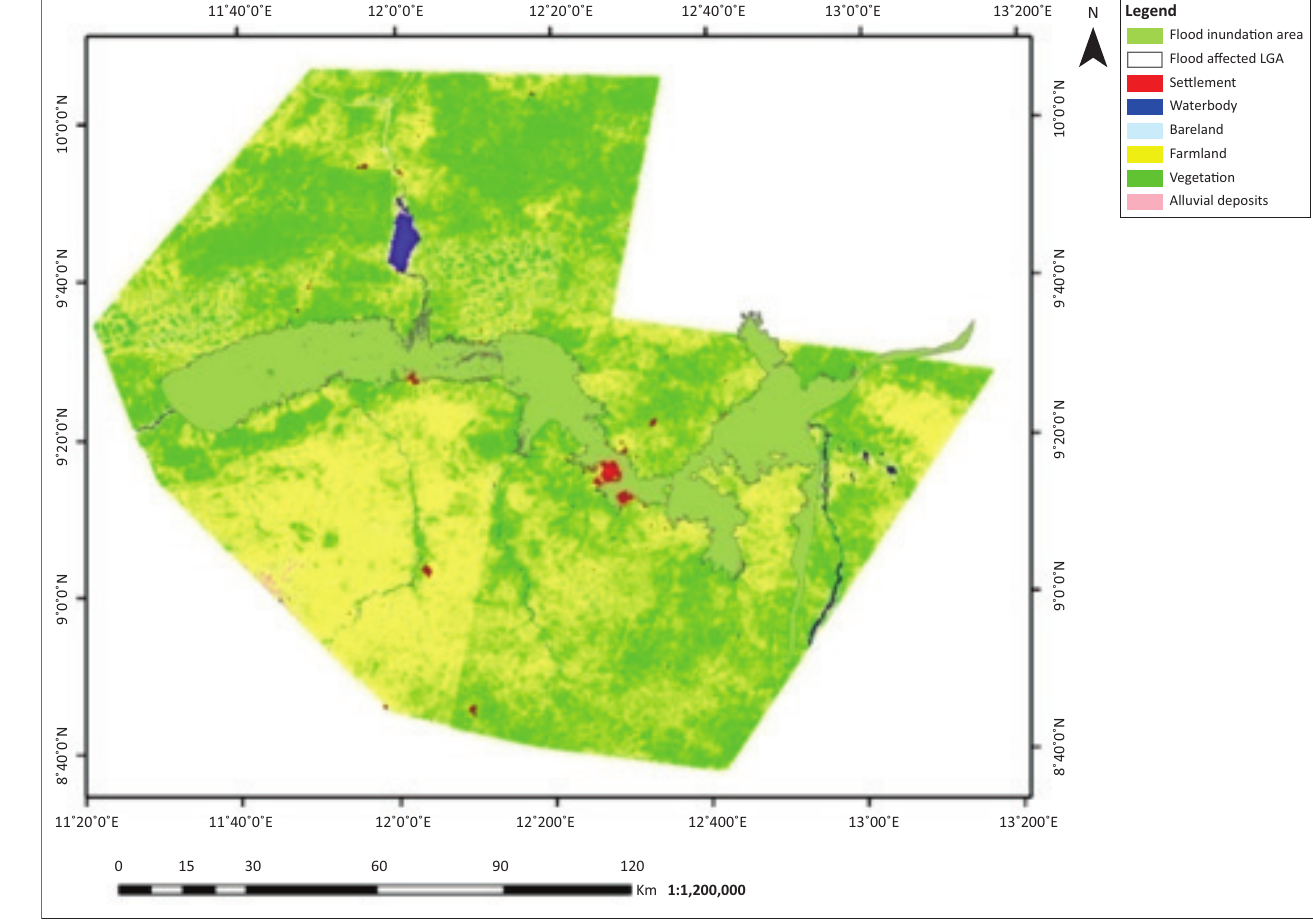
FIGURE 2: Flood inundation and land use and/or land cover of Adamawa